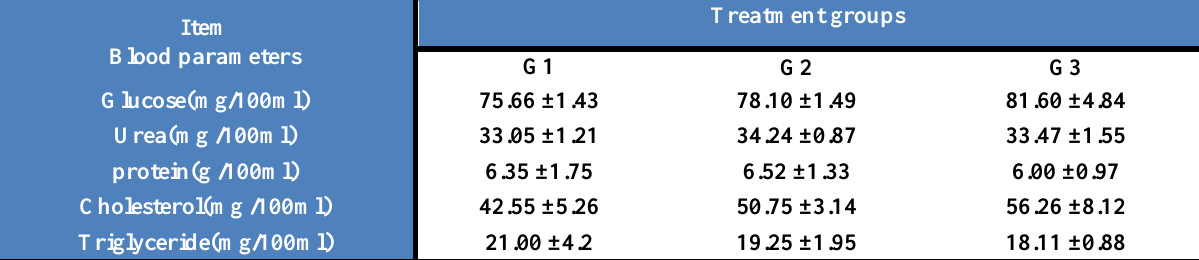
Table, 4: Effect of adding sunflower oil in the diet on the mean of blood parameters of ewes.